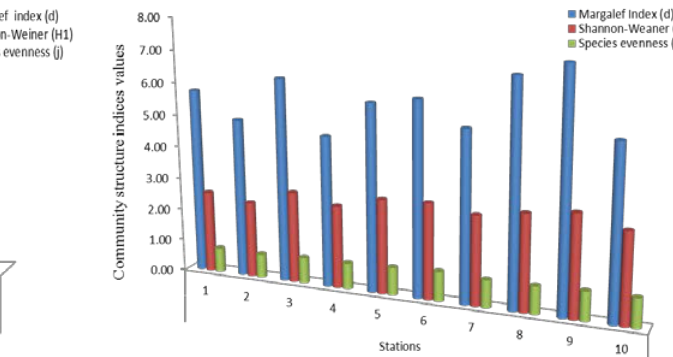
Fig. 1. Comparison of microalgal community structure indices at Oluwa and Ifara Rivers, Ondo State